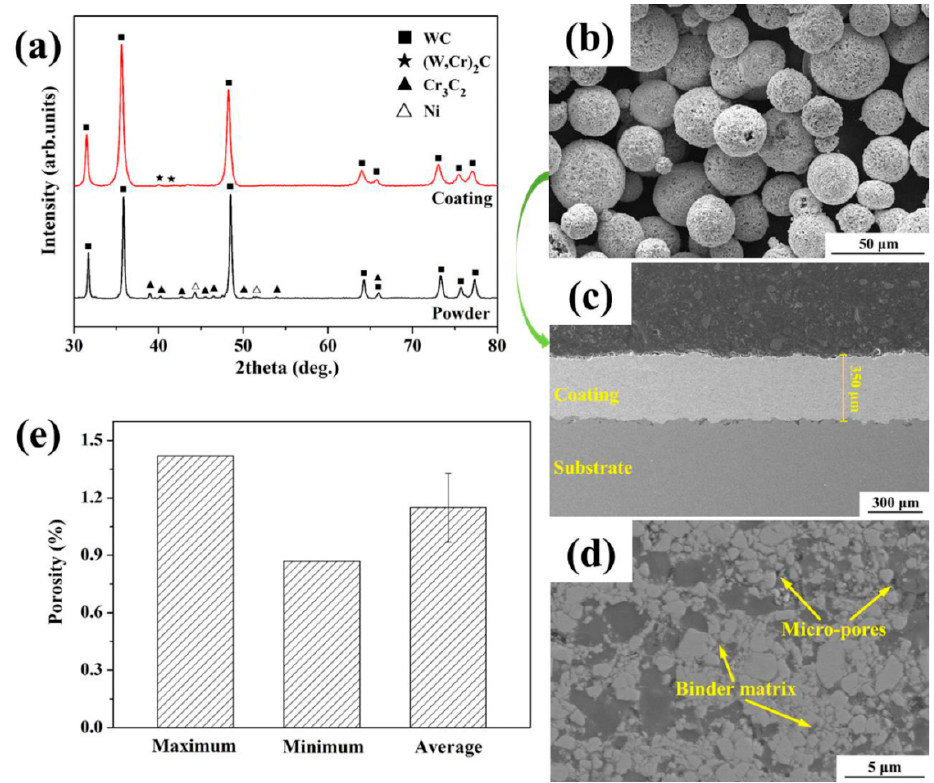
Figure 2. Phase constitutions and microstructures of the feedstock powder and the coating: ( a ) XRD patterns [23]; ( b ) surface morphology of the feedstock powder; ( c , d ) cross-sectional morphology of the coating; ( e ) porosity of the coating.